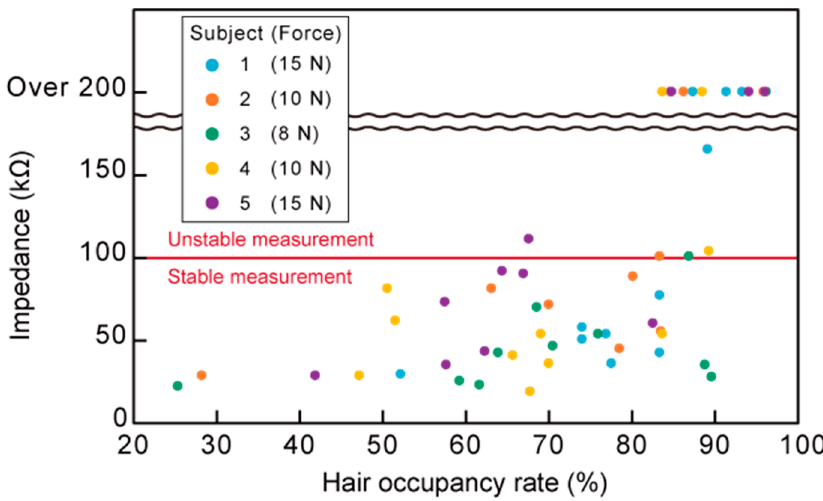
Figure 9. Measured impedance for various hair occupancy rates and contact forces for five different subjects. An impedance of 100 k Ω or less was considered sufficient to realize a stable EEG measurement.